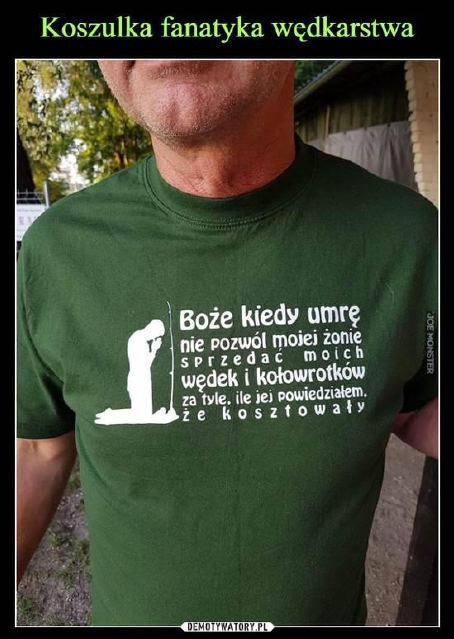
Figure 1. T-shirt of a fishing fanatic.